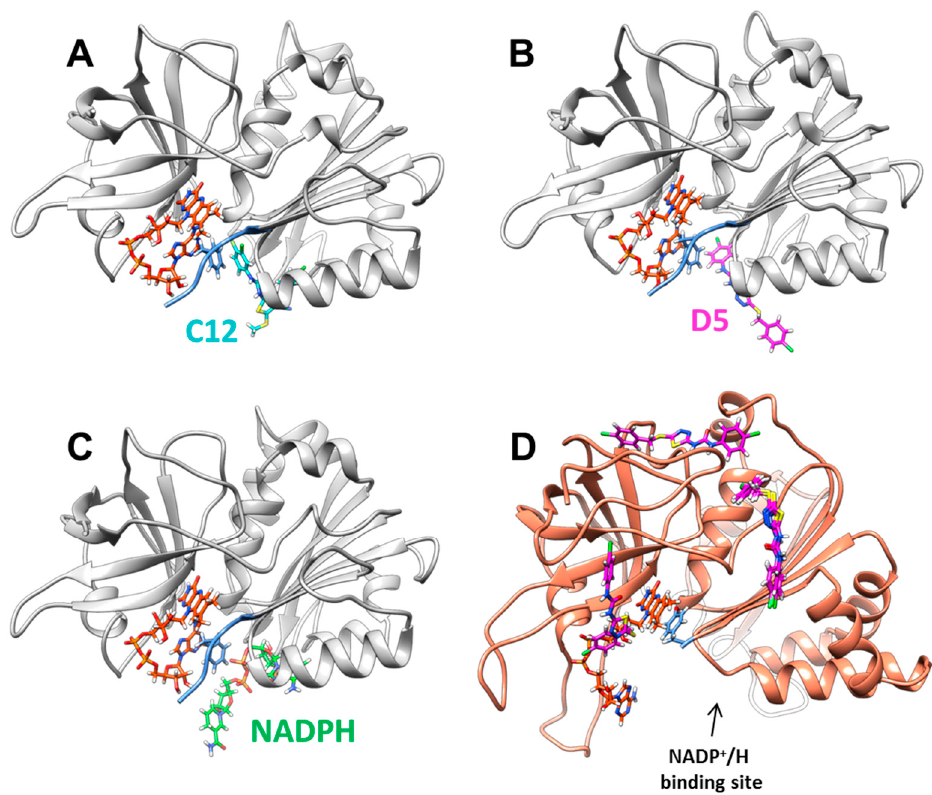
Figure 6. Binding pockets of selected ligands in the overall protein structure. ( A ) Model for the best docking pose of Xcc FPR:C12 after MD refinement. ( B ) Model for the best docking pose of Xcc FPR:D5 after MD refinement. ( C ) Theoretical binding of the NADPH substrate (based in PDB 4b4d for the protein and PDB 2vnj for the NADP + conformation as found in Rc FPR). ( D ) Four best docking clusters of An FNR:D5. Xcc FPR and An FNR are shown as grey and light salmon cartoons respectively. FAD, C12, D5 and NADPH are shown in CPK colored sticks with carbons in orange, light blue, pink and green respectively. The C-terminal extension of Xcc FPR and the C-terminal residue in An FNR are colored in blue.